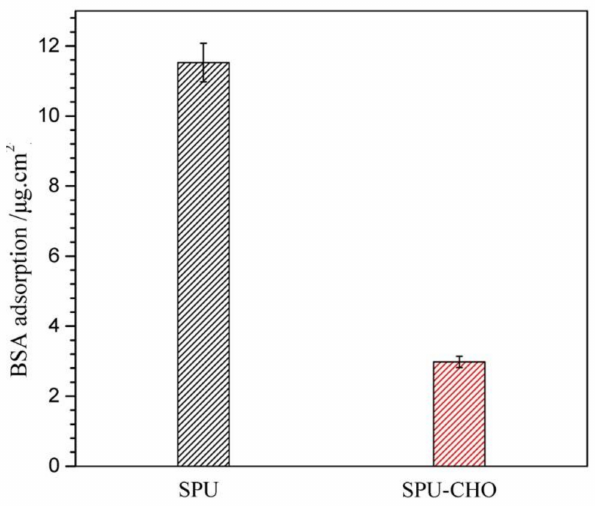
Figure 8. Quantity of absorbed BSA protein on the surface of SPU and SPU-CHO films ( n =